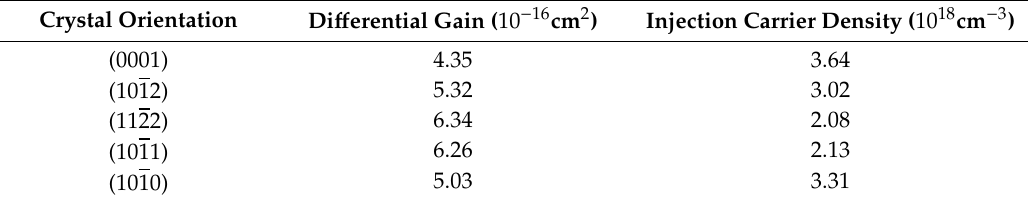
Table 4. Highest di ff erential gain as a function of injection carrier density in TE mode.